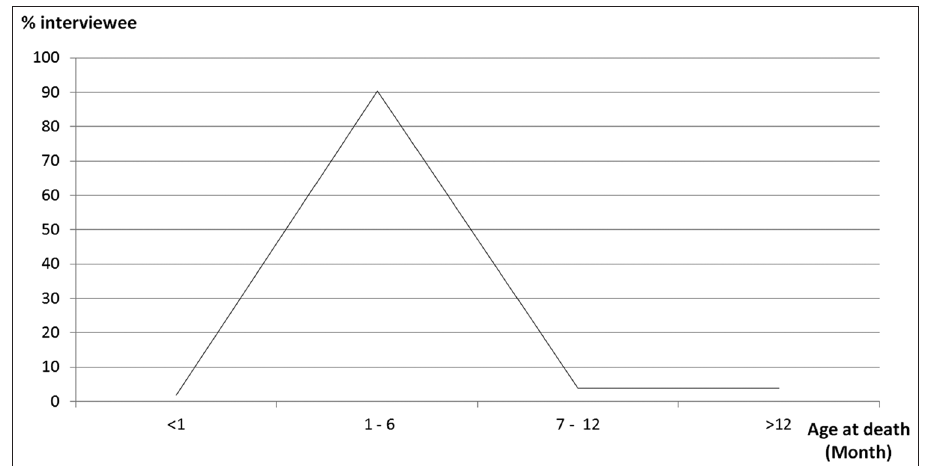
Figure-2: Percentage of age (month) of the chicken(s) at the point of death. Percentage was calculated based on the number of interviewee who had experienced mortality.